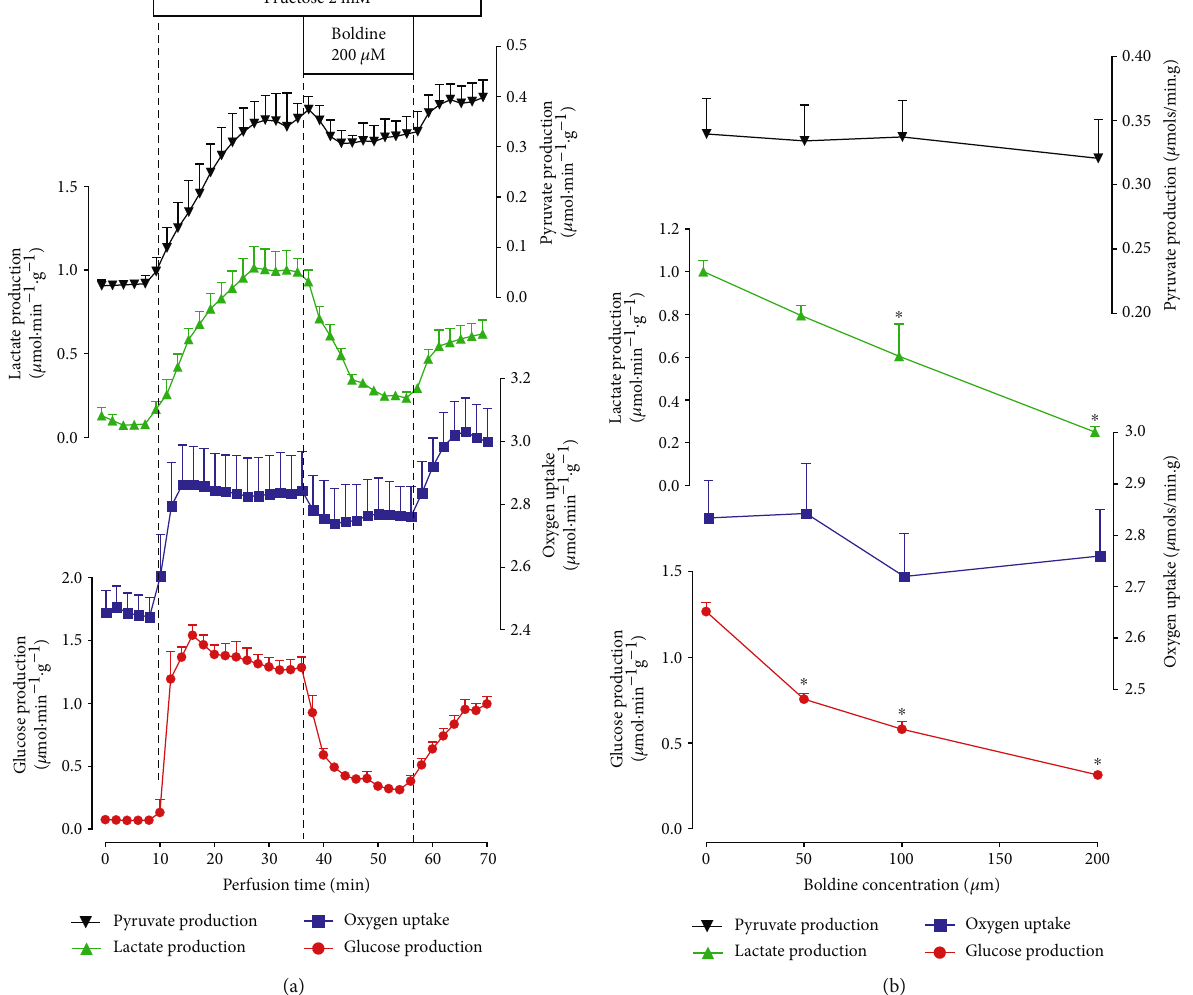
Figure 3: E ff ects of boldine on fructose gluconeogenesis in the perfused livers isolated from fasted rats. Time courses (a) and concentration- dependent e ff ects of boldine (b) on fructose gluconeogenesis and related parameters. Livers were perfused as described in the Materials and Methods. In (a), data are the means ± meanstandard errors of 4 liver perfusion experiments. Boxes near to the time scale indicate the fructose and boldine infusion periods and concentrations. In (b), the rates of pyruvate, lactate, and glucose productions and oxygen uptake were evaluated at 36 minutes of perfusion time (control condition, zero boldine concentration; n = 12 ) and at 56min perfusion time ( n = 4 ). Asterisks ( ∗ ) in (b) indicate those rates that di ff er from the control condition (absence of boldine; p ≤ 0 : 05